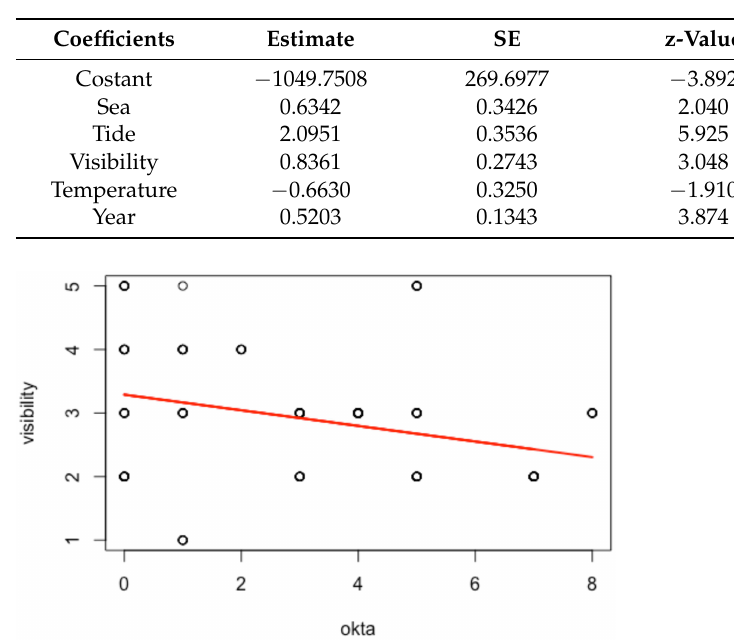
Table 3. Logit regression model accounting for all the five environmental factors across units over time. Here, ‘Coefficients’ refers to the factors within the model; ‘Estimate’ denotes b k (the estimated β k ); ‘SE’ stands for standard error; ‘z-value’ denotes the test statistic obtained for each predictor; and ‘Pr (>|z|)’ refers to the associated p -value in a two-sided hypothesis test (where the null accounts for non-significance). The significance levels are: (**) significance at 5%; and (***) significance at 1%.